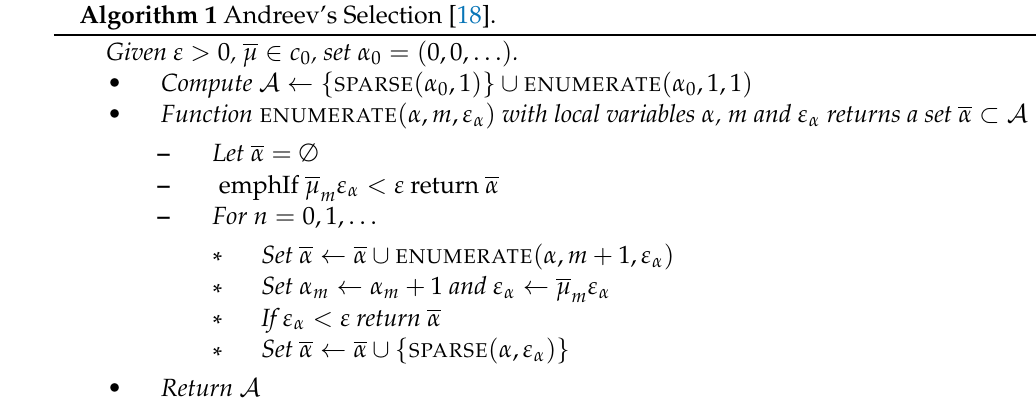
Algorithm 1 Andreev’s Selection